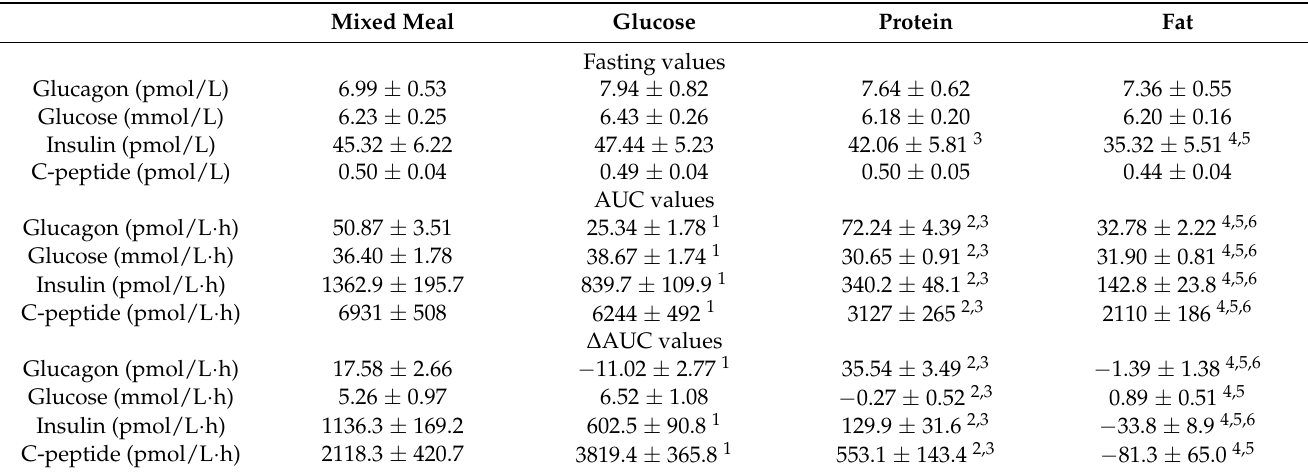
Table 1. Fasting values, area under the curve (300 min), and related suprabasal component (AUC and ∆ AUC, respectively) for plasma glucagon, glucose, insulin, and C-peptide, after ingestion of a mixed meal or single macronutrients in a cohort of 36 subjects (18 subjects with normal glucose tolerance and 18 subjects with type 2 diabetes). Data are mean ±